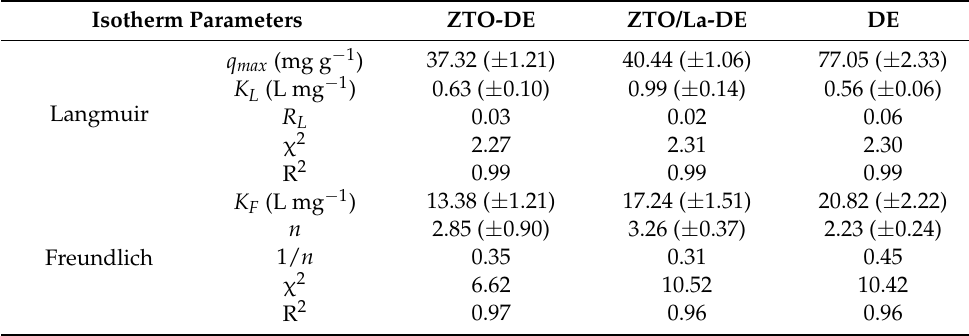
Table 3. Isotherm parameters for MB adsorption on